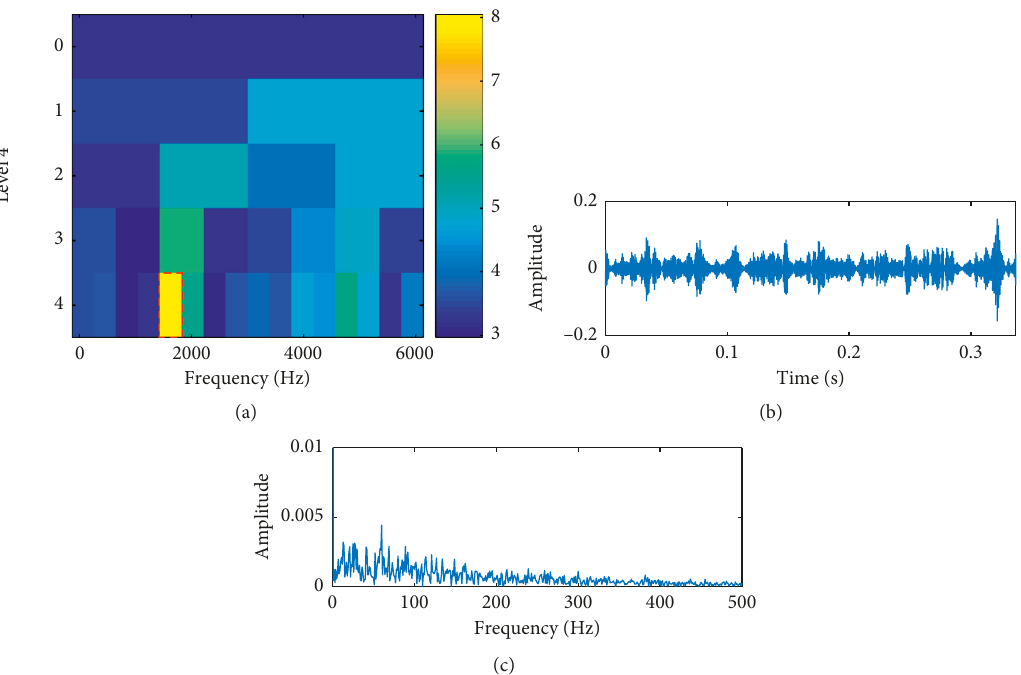
Figure 13: Diagnosis results of the single fault experimental signal by WPT-FSK: (a) kurtogram; (b) TW of the filtered signal with the maximal kurtosis; (c) ES of (b).